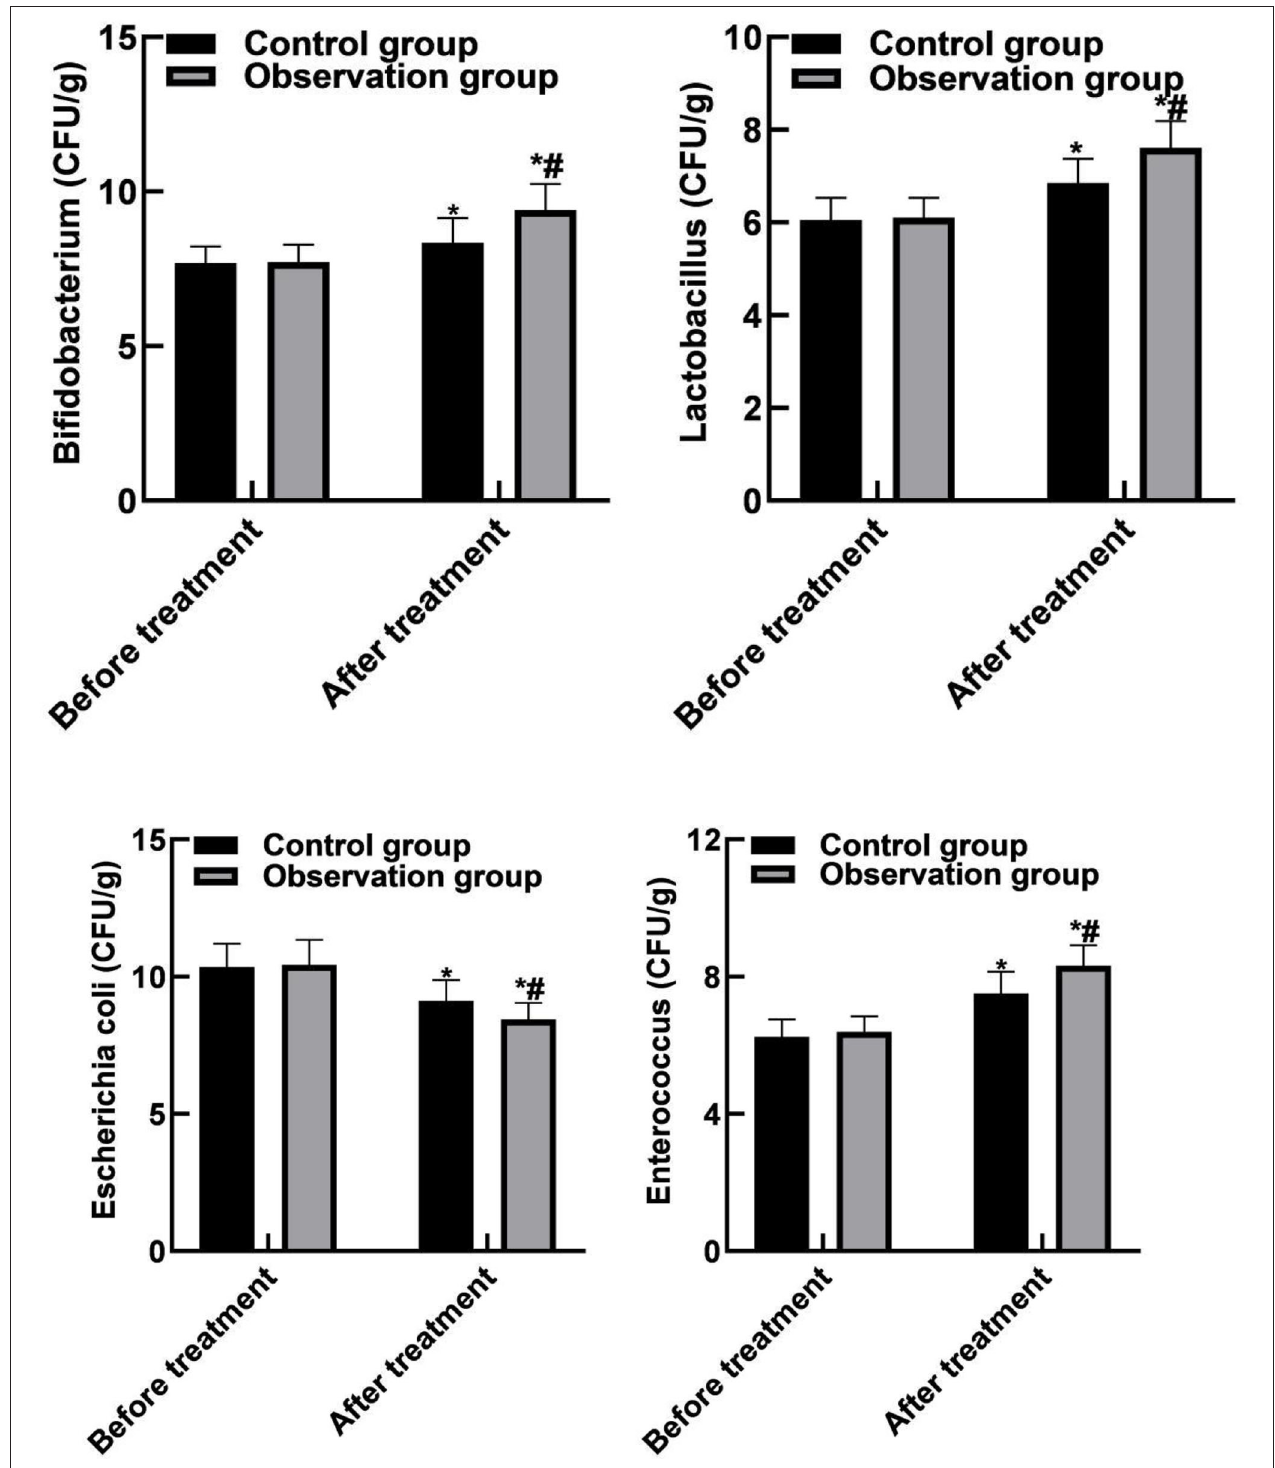
FIGURE 3 | Comparison of intestinal flora indicators between the two groups. Compared with before treatment, * P < 0.05. Compared with the control group, # P < 0.05.